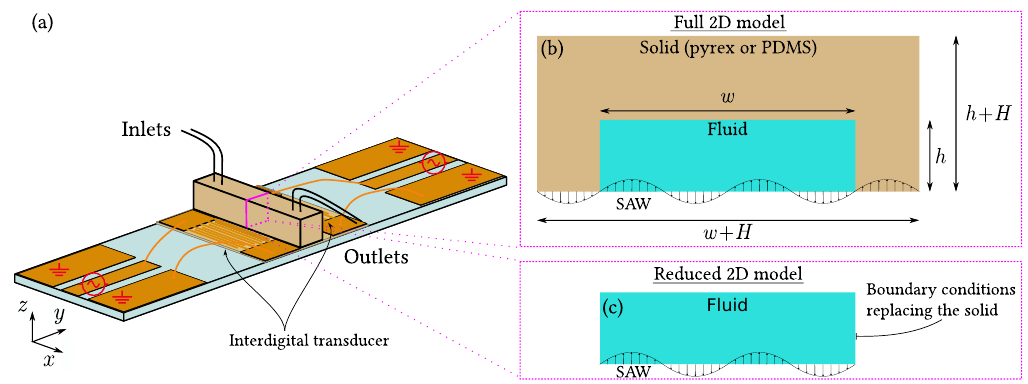
Figure 1. ( a ) Sketch of the generic acoustophoretic device under study. A fluid flows through a long straight microchannel defined by a surrounding solid wall (pyrex or polydimethylsiloxane (PDMS), light brown ) and placed on top of a piezoelectric substrate ( light blue ). By actuating the interdigital transducers (IDTs, dark brown ) placed on either side of the device, surface acoustic waves (SAW) propagate along the surface of the substrate, and when timed properly they form a standing wave; ( b ) Sketch in the transverse yz cross-section of the full 2D model consisting of a solid domain with wall thickness H and a fluid domain of width w and height h ; ( c ) Similar sketch of the reduced 2D model, which consists solely of the fluid domain in ( b ), but with boundary conditions (hard wall or lossy wall) representing in an approximate manner the surrounding